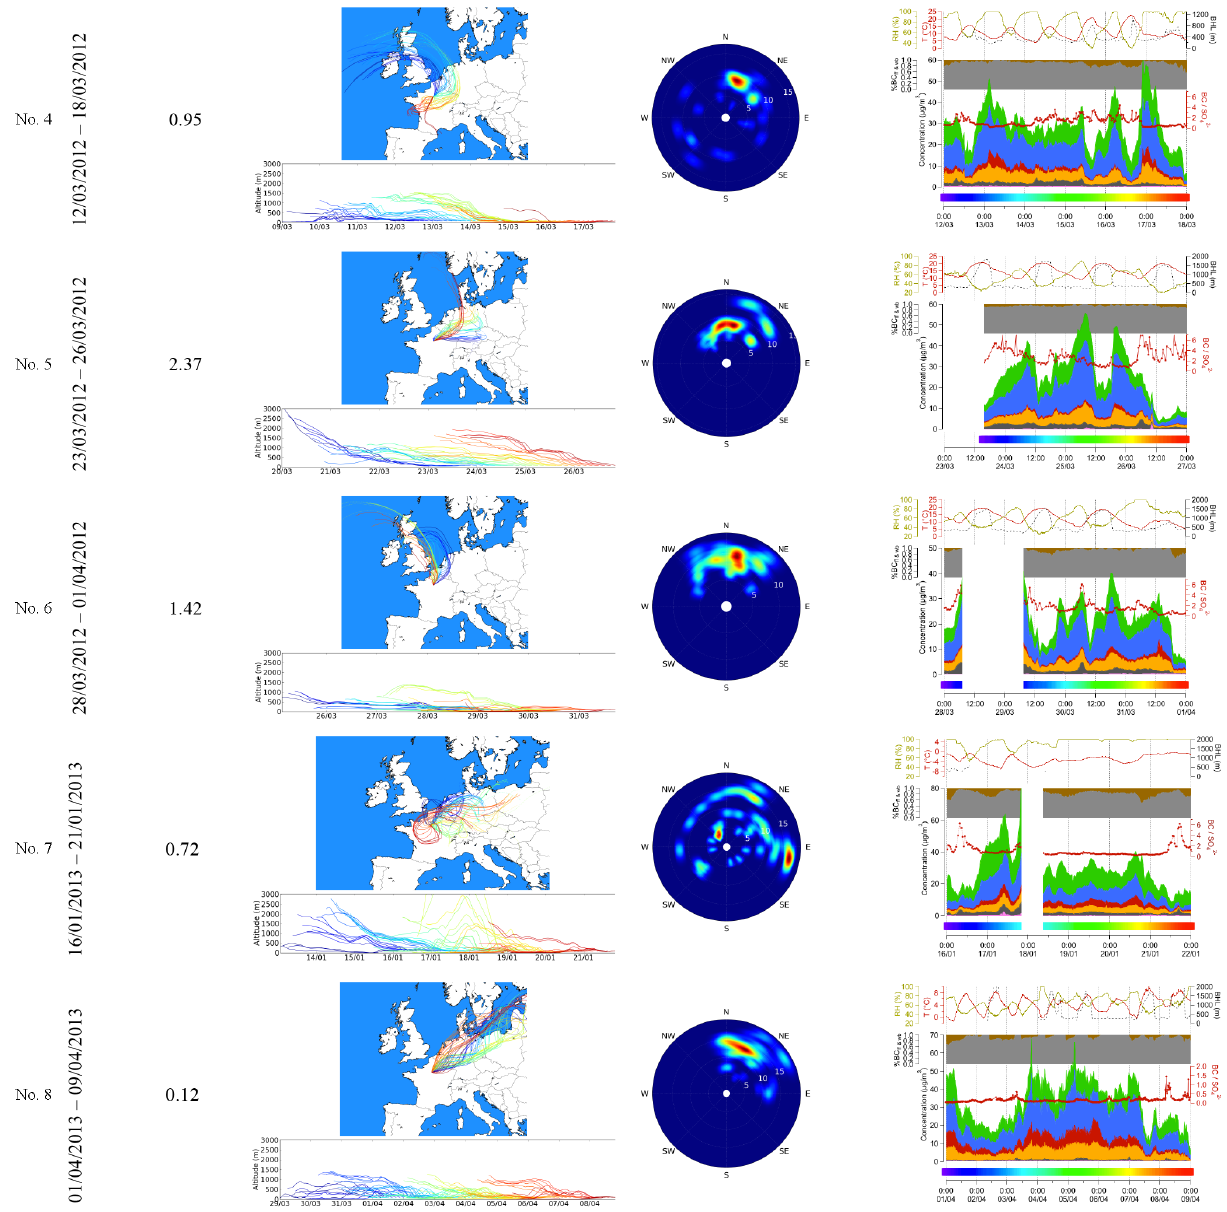
Figure 13. Illustration of meteorological conditions and chemical composition during the eight pollution episodes. Left graphs represent 72h backtrajectories ending at SIRTA at 100ma.g.l. every 3h and their altitude; middle graphs illustrate the wind rose (radial axis in kmh − 1 ); right graphs represent the chemical composition, in µgm − 3 of submicron particles (organic, nitrate, sulfate, ammonium, chloride and black carbon in green, blue, red, orange, pink and dark grey, respectively), the contribution of traffic and wood burning to BC, the BC / SO 2 − and temperature, RH and